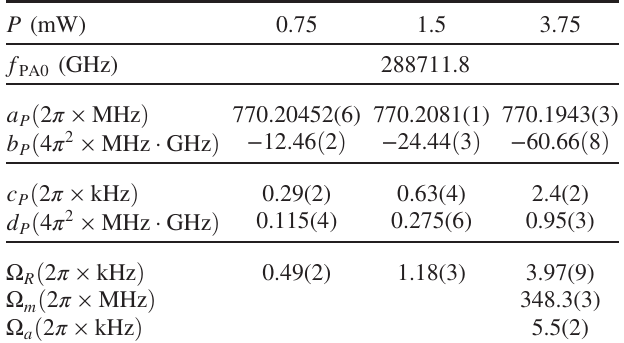
TABLE I. Fitting results for Figs. 4(a) and 4(b). Ω R is reported at − 151 GHz detuning from the v 0 ¼ 0 state. At 3.75 mW, Ω = Ω ¼ 0 . 016 , near the theory prediction of 0.013. The m a measured Rabi rate Ω R is only 63% of Ω m Ω a = ð 2 Δ Þ due to interference from further-detuned Raman processes.